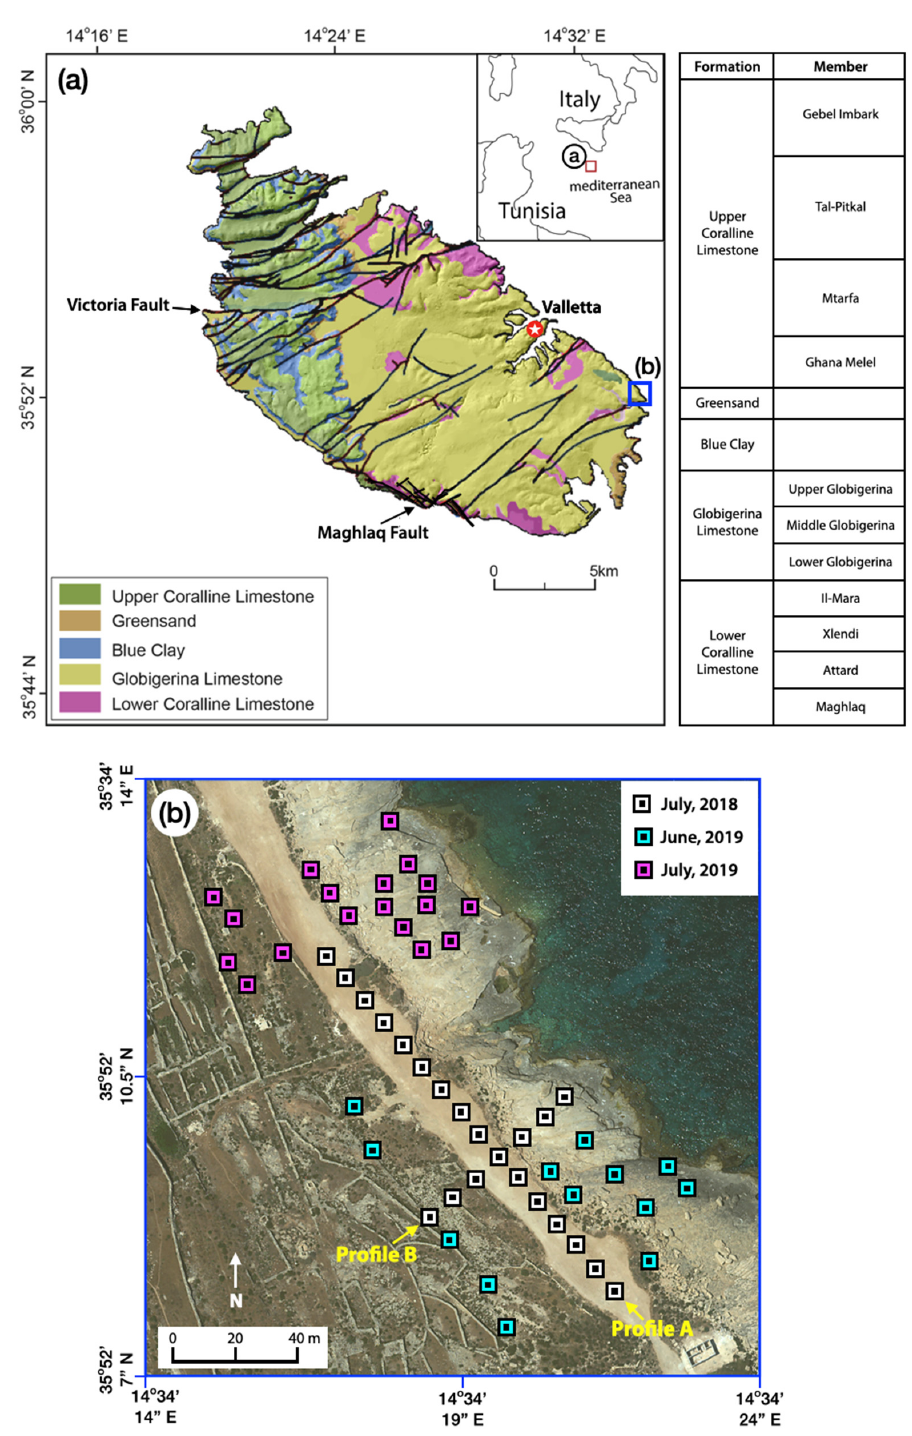
Figure 1. ( a ) Geological map of the island of Malta and an inset map showing location of Malta in the Mediterranean Sea as a red square. Modified from Geological Map of Maltese Islands, 1993 [19]. Black lines denote faults. The lithological profile is provided in the right panel. Study site is shown as blue square. ( b ) Detail of the study site in SE Malta; transect A is aligned NW–SE and B is aligned NE–SW. Time-domain electromagnetic (TDEM) soundings are marked as squares with black squares inside; the di ff erence in colors denotes di ff erent acquisition dates. White symbols show TDEM sounding locations from July 2018. Additional soundings investigated during June and July 2019 are indicated by cyan and purple symbols, respectively.